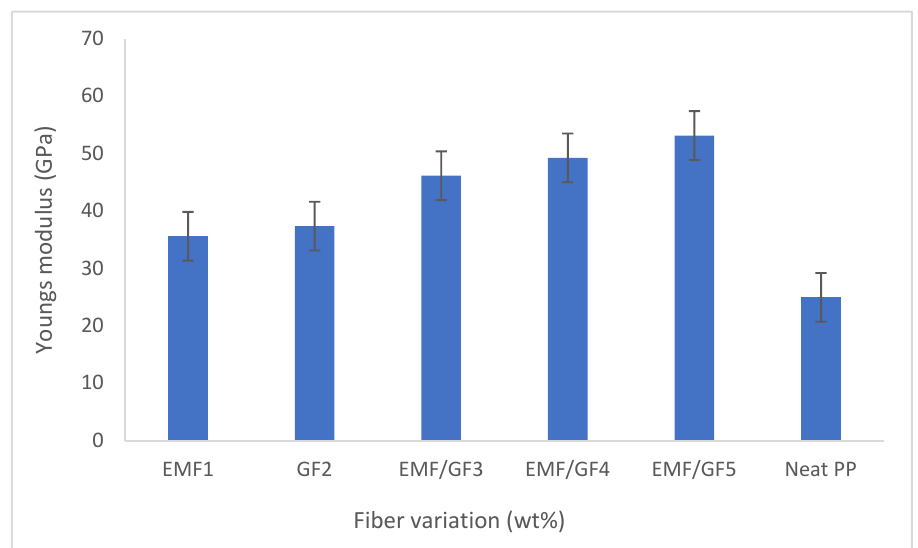
Figure 6. Young’s modulus of the hybrid reinforced composites.